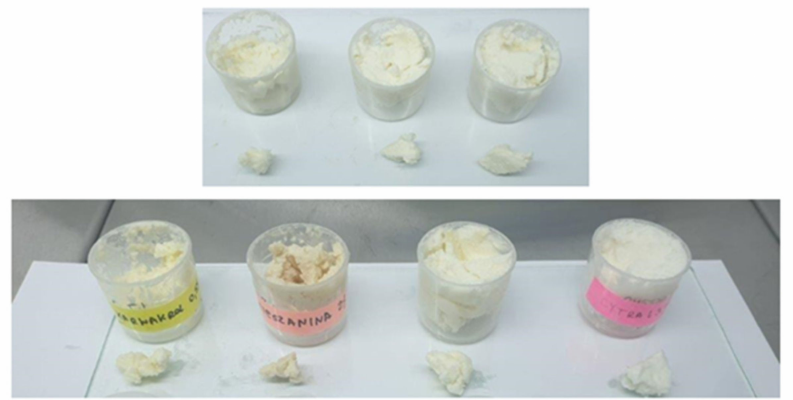
Figure 1. Pictures of prepared creams with the addition of (from the left): carvacrol, the mixture after isomerization of S-carvone, geraniol and